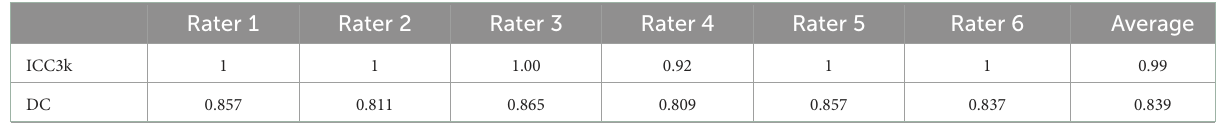
TABLE 2 Intra-rater